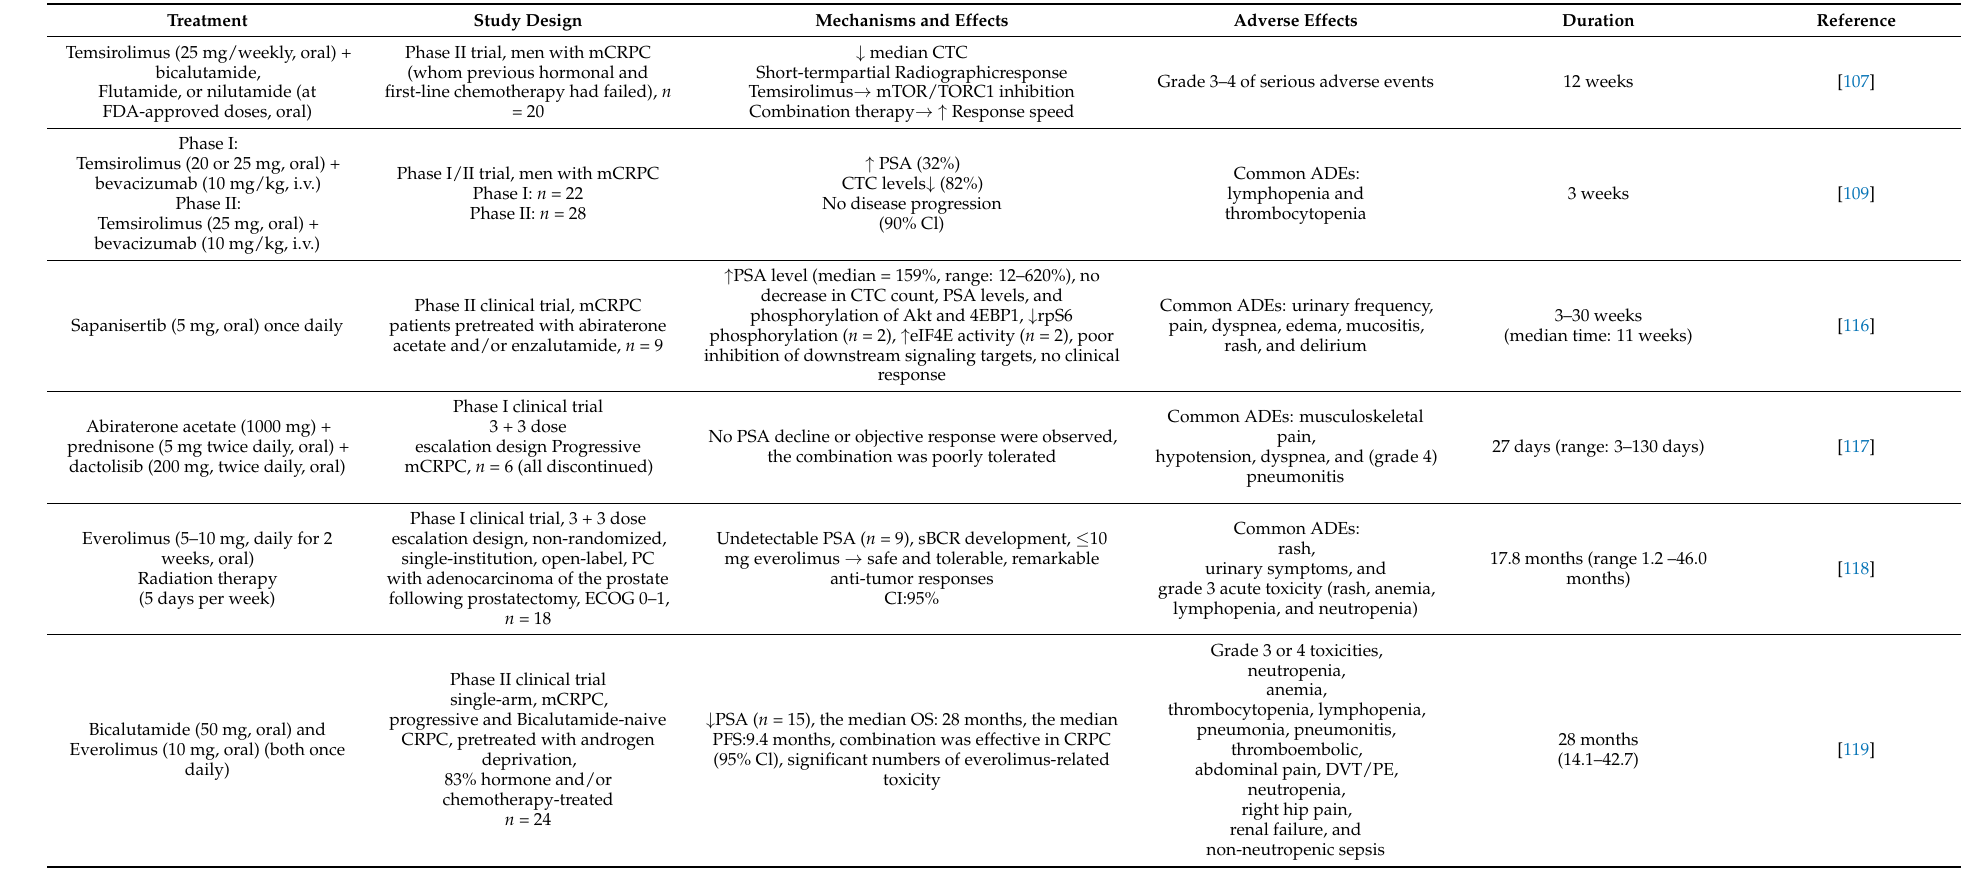
Table 3. Clinical studies on PI3K/Akt/mTOR inhibitors in prostate